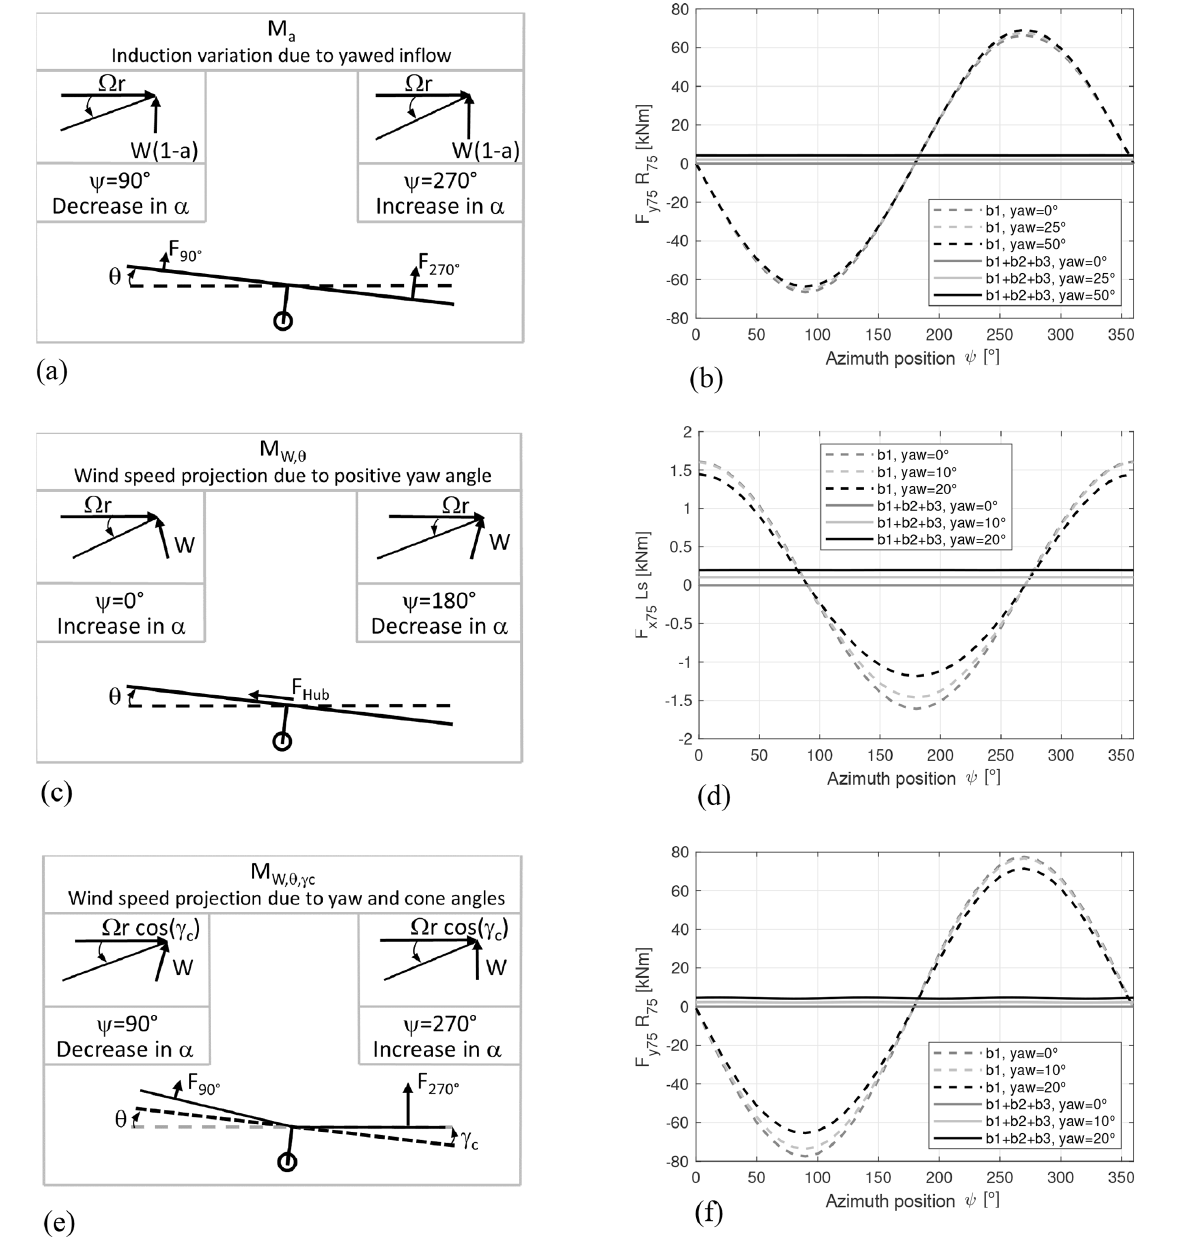
Figure 2. Aerodynamic mechanisms for yaw stiffness of a downwind rotor (a, c, e) and the roughly estimated respective variation in yaw moment of the force at 75% rotor radius for wind speeds of 12ms − 1 over azimuth position (b, d, f) .